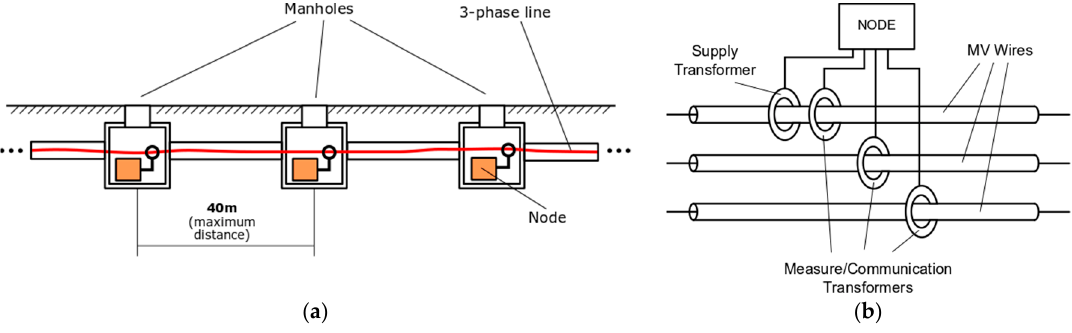
Figure 4. ( a ) Primary distribution line segment; and ( b ) Node installation in a manhole.